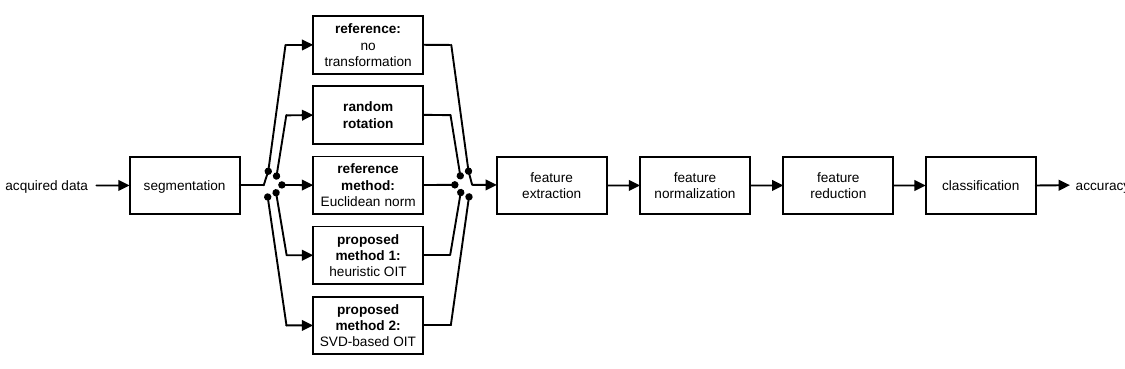
Figure 5. Activity recognition